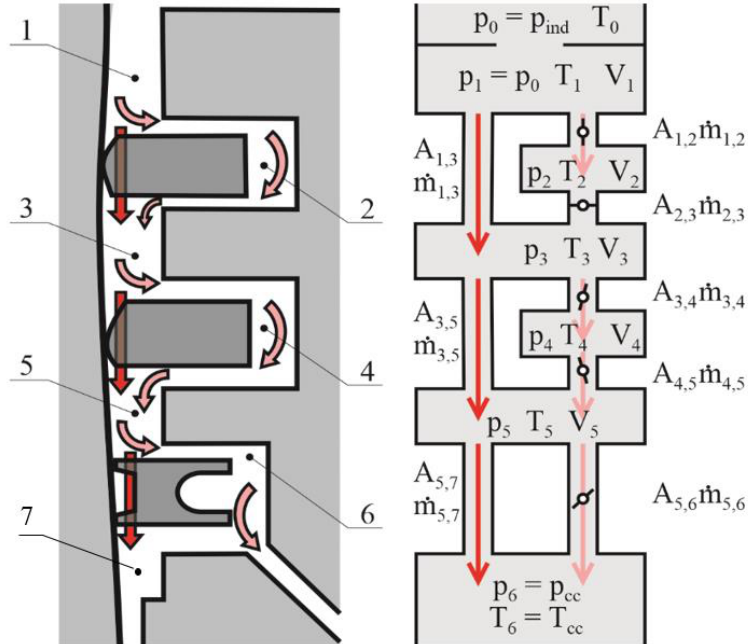
Figure 1. A schema of the ring pack and corresponding orifice-volume model; 1—top land, 2 and 4—behind ring spaces, 3—the second land, 5—the third land, 6 and 7—spaces connected to the